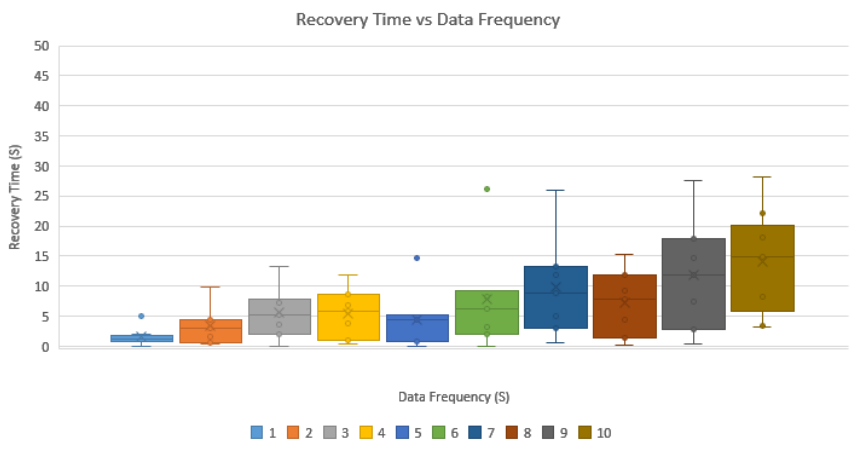
Figure 11. Recovery time vs. Data